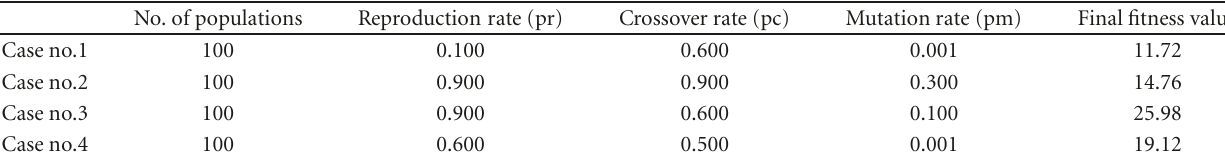
Table 2: Preliminary test parameters of GA.